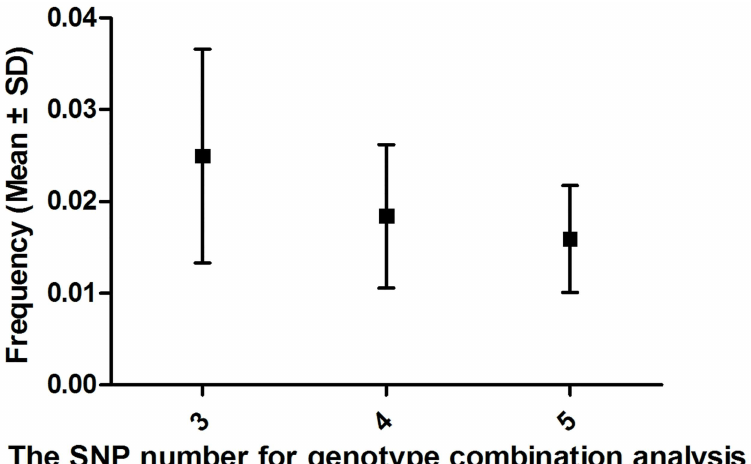
Fig 3. Frequency of genotype combination patterns for three, four and five SNPs in inverse